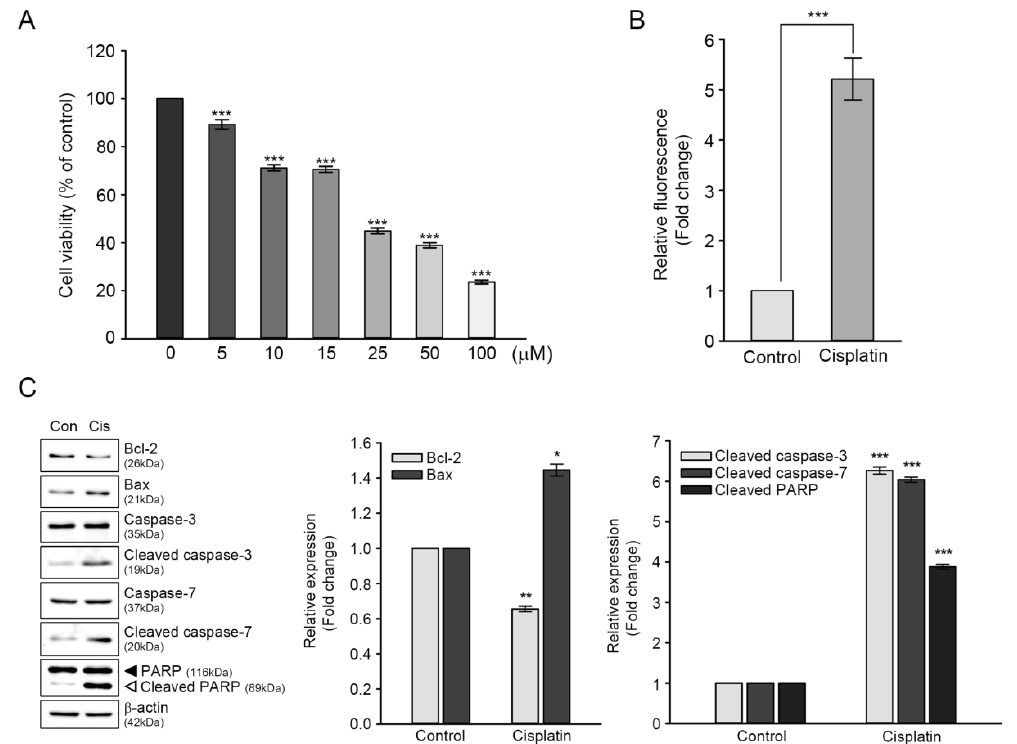
Figure 1. Effects of cisplatin on viability, reactive oxygen species (ROS) generation, and expression of apoptosis-related proteins of HEI-OC1 cells. Cells were treated with various concentrations of cisplatin (5–100 μM) for 24 h. ( A ) Cell viability was determined through CCK assay. Values are expressed as means ± SE of four independent experiments, expressed as a percentage of untreated control values. *** p < 0.001, compared with untreated control. ( B ) Intracellular ROS accumulation was measured through DCF fluorescence intensity spectrofluorometry. Values are expressed as means ± SE of four independent experiments, expressed as a percentage of untreated control values. *** p < 0.001, compared with untreated control. ( C ) Representative immunoblotting result showing the expression of apoptosis-related proteins. After treatment with 25 μM of cisplatin for 24 h, the cells were harvested for immunoblotting of each protein. Protein bands were quantified using densitometry, and their abundances were expressed relative to β-actin band density. The ratio of each protein to β-actin is presented as a fold change of that of the untreated control. Values are expressed as means ± SE of three independent experiments. * p < 0.05, ** p < 0.01, *** p < 0.001; compared with the untreated control.